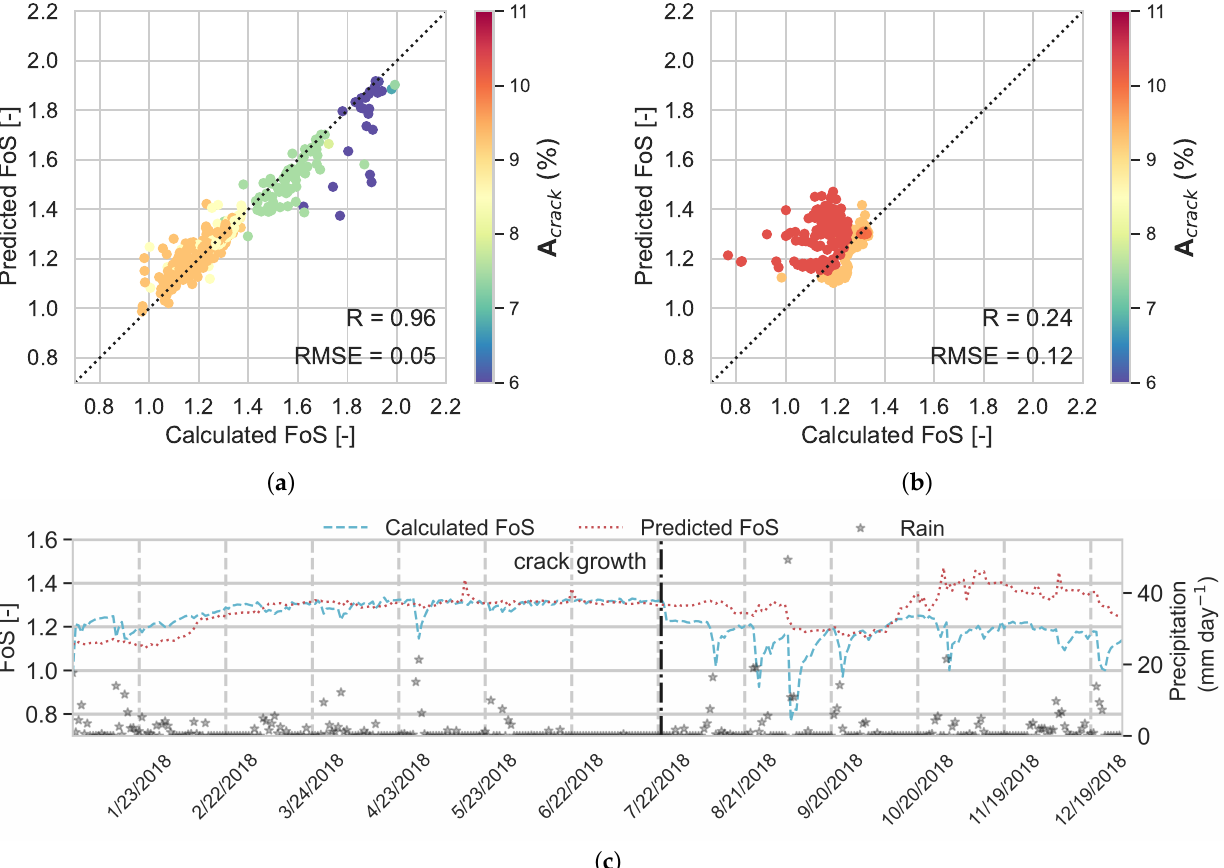
Figure 14. RF stp ,5 d model performance, over ( a ) the testing data set and ( b ) the independent data set, and ( c ) time series of predicted and calculated FoS in the independent data set (year